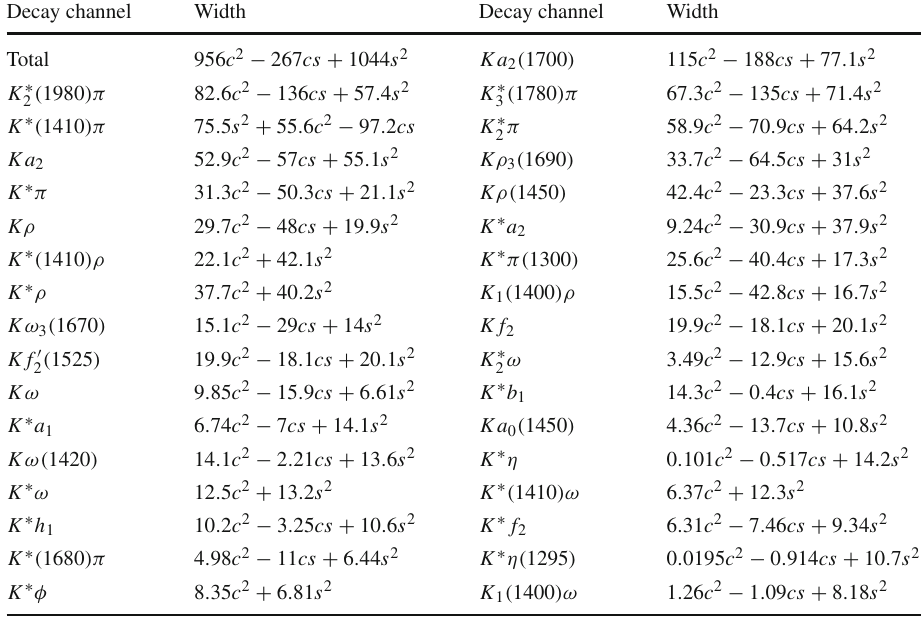
Table 11 The main strong decay widths of K 2 ( 1990 ) as an 2 D state, where s and c represent sine and cosine functions. The unit of the width is MeV Decay channel Width Total